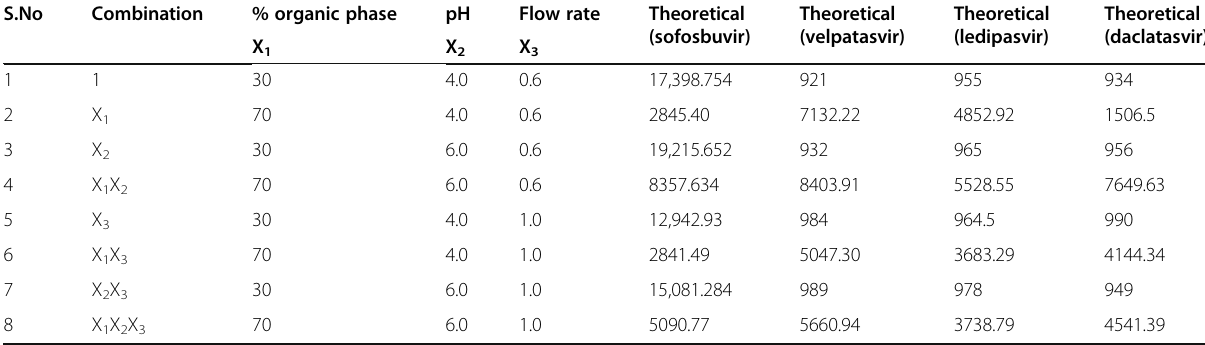
Table 2 System response of sofosbuvir, velpatasvir, ledipasvir, and daclatasvir in complete composite design S.No